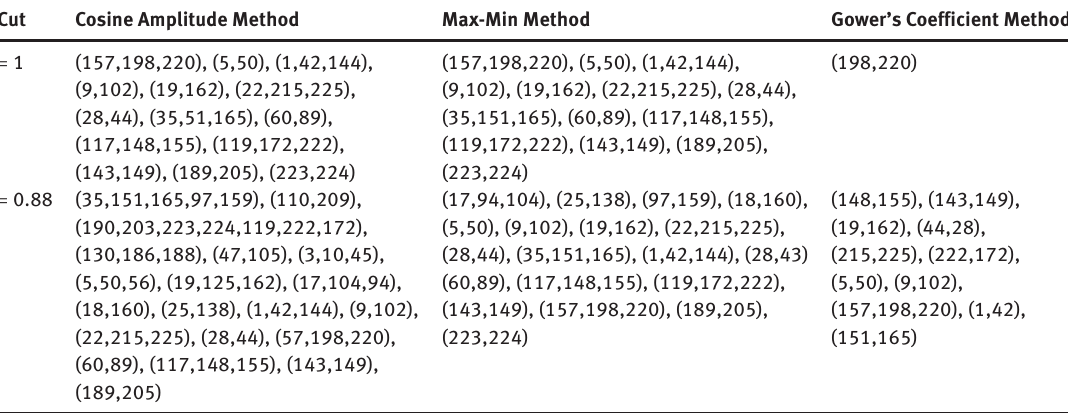
Table 9: Classification of Patients: Using Cosine Amplitude, Max-Min Method, Gower’s Coefficient Method (226